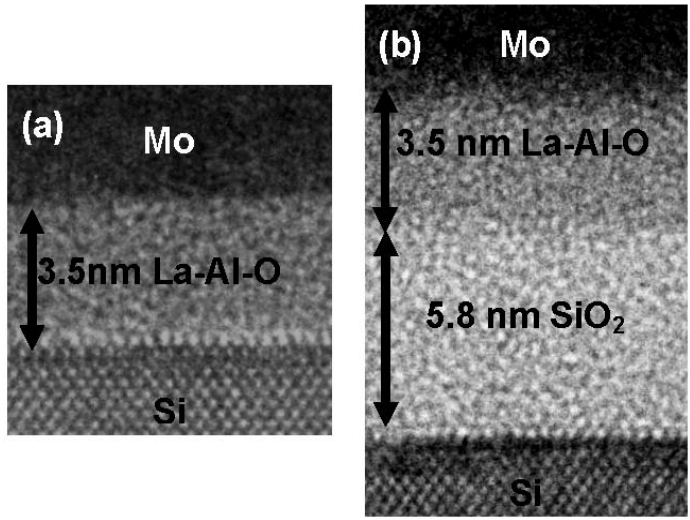
Figure 32. TEM images for ( a ) Mo/La-Al-O/Si and ( b ) Mo/La-Al-O/SiO with La/(La+Al) =